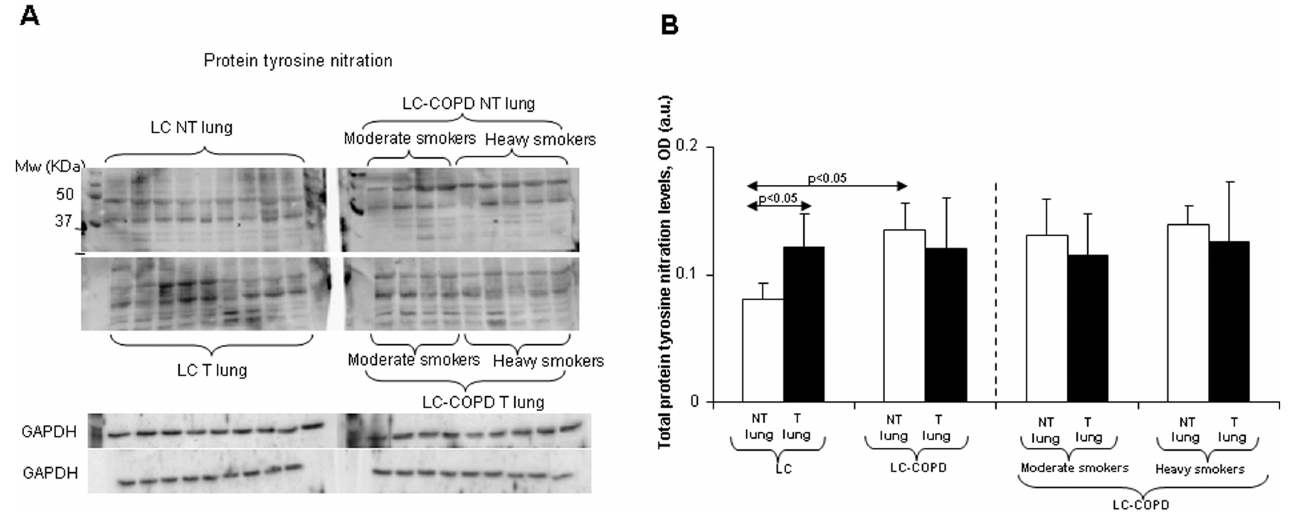
Figure 2. (A) Immunoblots of total protein tyrosine nitration in the lung tumor (T) and nontumor (NT) of LC and LC-COPD patients. (B) Mean values and standard deviation (optical densities [OD] expressed in arbitrary units [a.u.]) of total protein tyrosine nitration levels were significantly increased in the tumor (T) lesions compared with nontumor (NT) lungs in LC patients. Total protein tyrosine nitration was also significantly higher in nontumor (NT) lung specimens of LC-COPD as a group compared with nontumor (NT) parenchyma of LC patients. The absence of any statistical sign means that no significant differences were found between groups for the different study comparisons. MW, molecular weights; KDa,